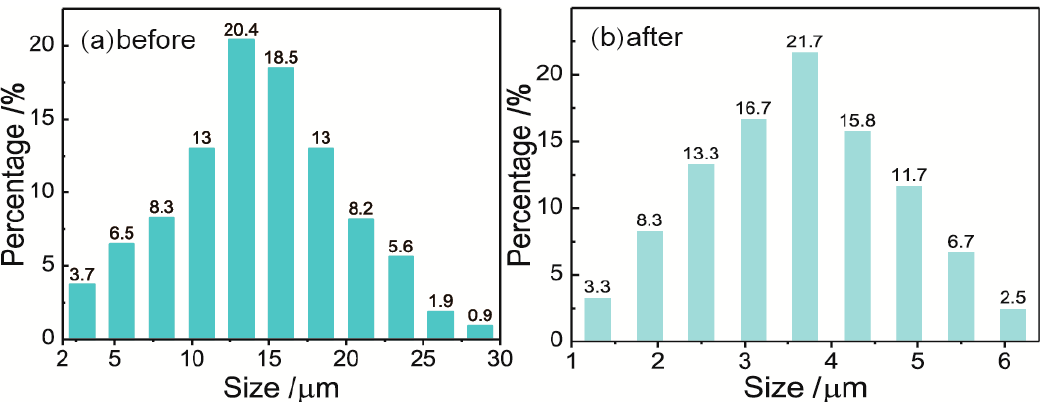
Figure 8. Droplet size distributions of water in oil (W/O) emulsions before ( a ) and after ( b ) having been demulsified by 3D-ESPM. Microchannel height: 200 μ m, arc radian: 180°, electric field intensity: 250 V/cm, plate number: 18 and flow rate: 2 mL/min.